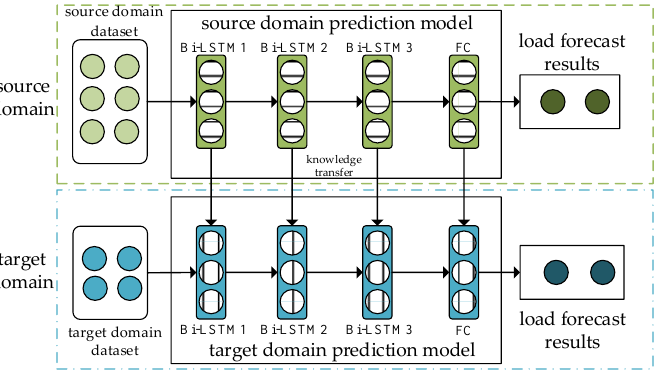
Figure 6. Transfer learning principle.